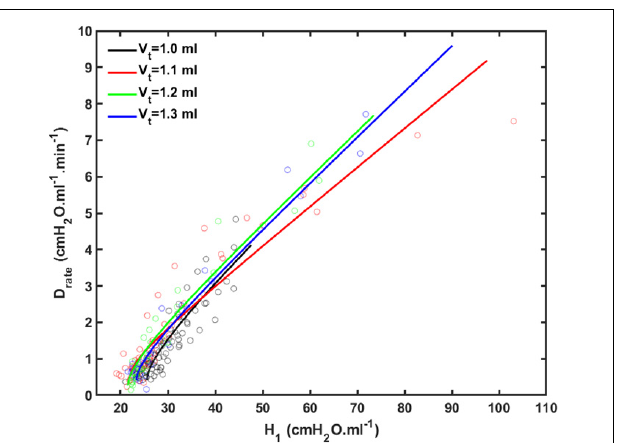
FIGURE 3 | Joint paired 95% confidence regions for the model parameters. The optimum parameter values (those that minimize the root mean squared difference between measured and modeled D rate ) are located at the centers of the ellipses. Black: V t = 1.0 ml; Red: V t = 1.1 ml; Green: V t = 1.2 ml; Blue: V t = 1.3 ml.